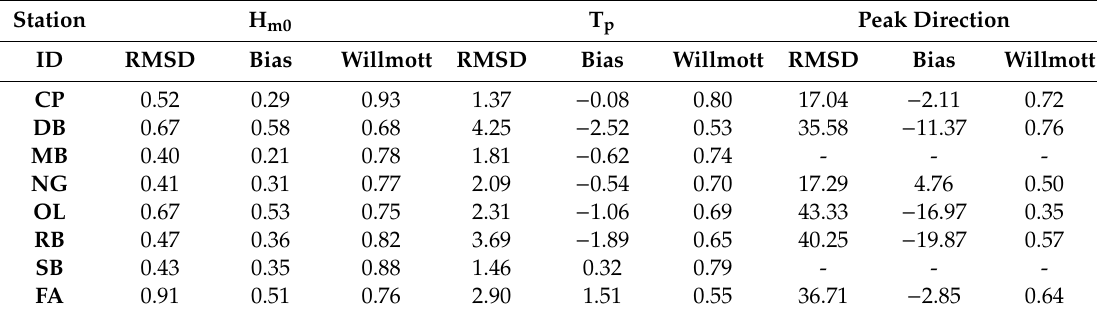
Table A6. Model performance statistics per coastal buoy location for JJA 2017,